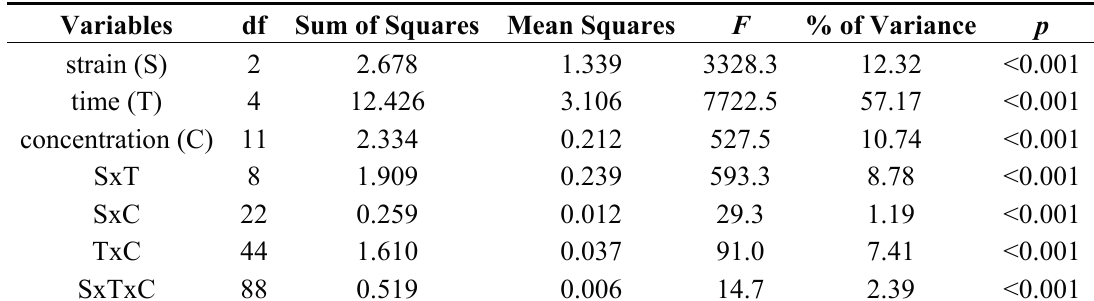
Table 2. Multivariate analysis of variance by three-way ANOVA of oral streptococci susceptibility to BECl expressed by standard microdilution susceptibility test. The comparisons and interactions between “strain”, “time” and “concentration” factors were statistically significant ( p < 0.001).